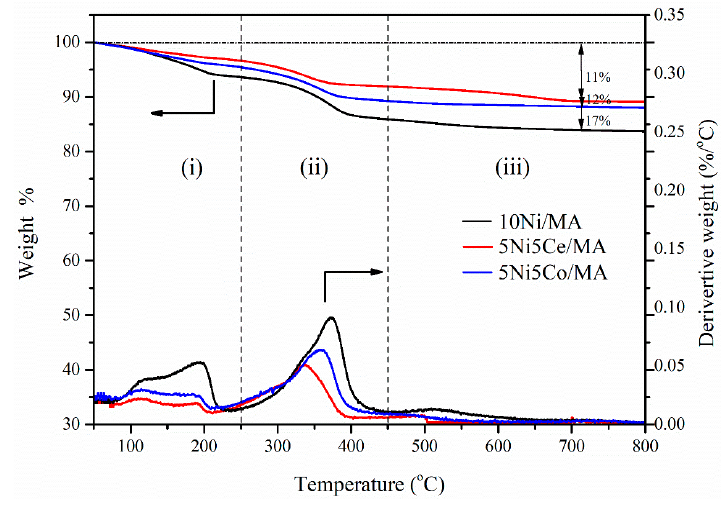
Figure 7. Thermogravimetric analysis (TGA) profile of spent catalysts.